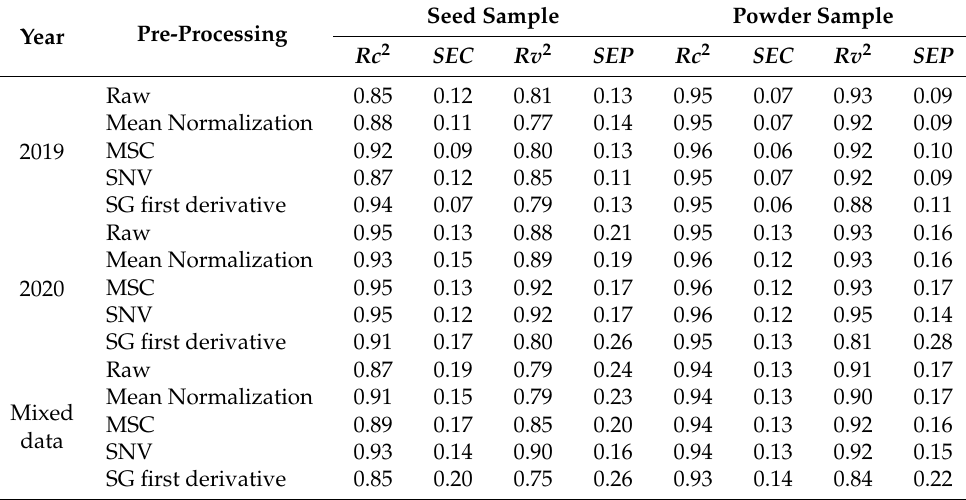
Table 3. The partial least square regression (PLSR) model developed for predicting anthocyanins content in rice using short wave infrared hyperspectral technique by applying the different pre- processing